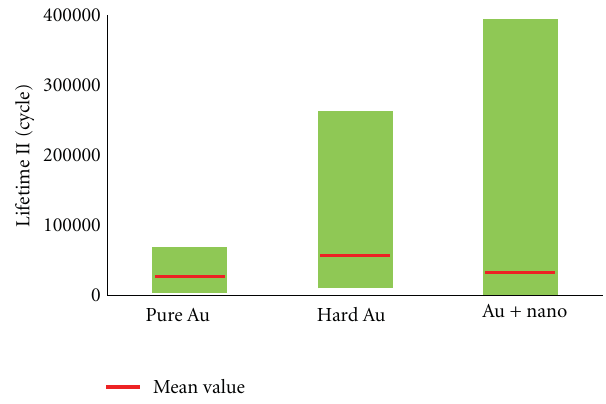
Figure 7: E ff ect of nanoscale